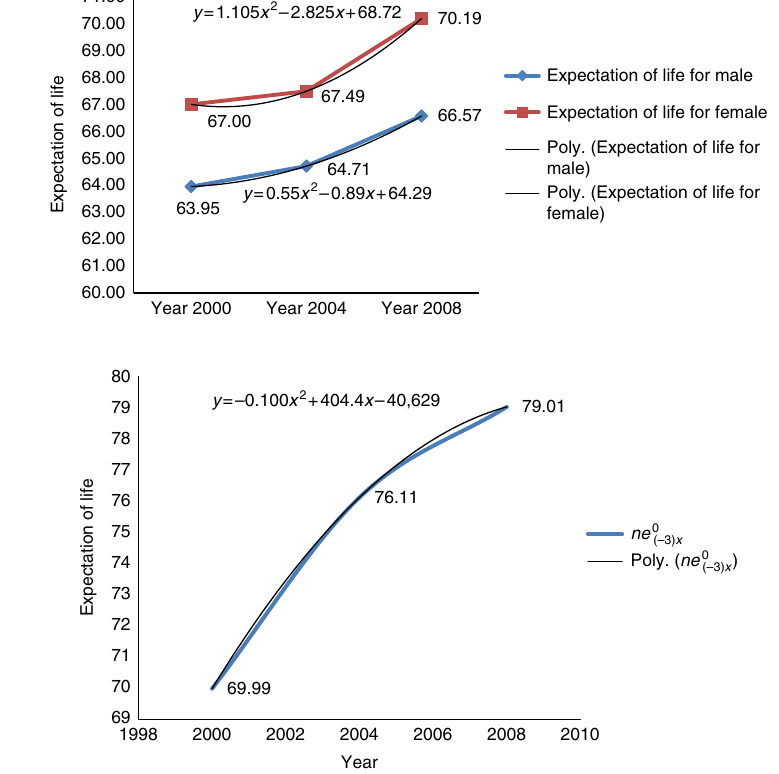
Figure 4. Expectation